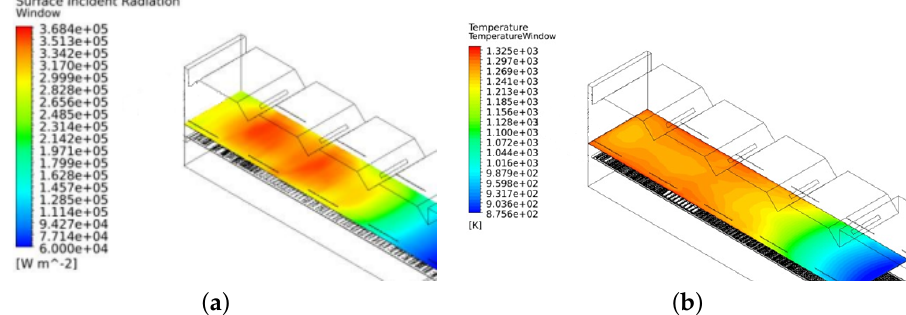
Figure 14. Iso-contours on window surface for: ( a ) incident radiation; and ( b ) temperature.